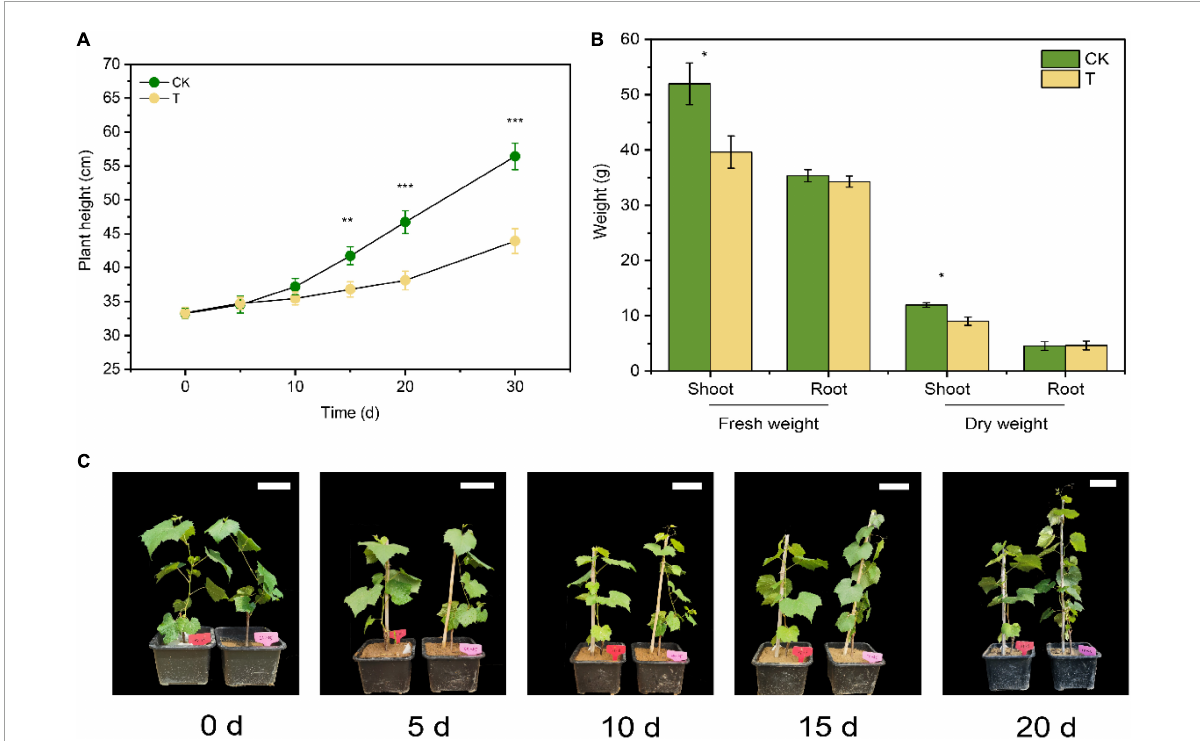
FIGURE2 Effects of 4-HBA treatment (T) on seedlings growth. (A) Effects of 4-HBA treatment (T) on plant height of grapevine seedlings. (B) Dry and fresh weights of shoots and roots of seedlings treated with 4-HBA (T) for 30 days. (C) Pictures of seedlings growth during 4-HBA treatment. The white scale bar in the picture represents 10 cm. The asterisk indicates significant differences between CK and 4-HBA treatment (T) (Student’s t -test, * p < 0.05; ** p < 0.01; *** p <